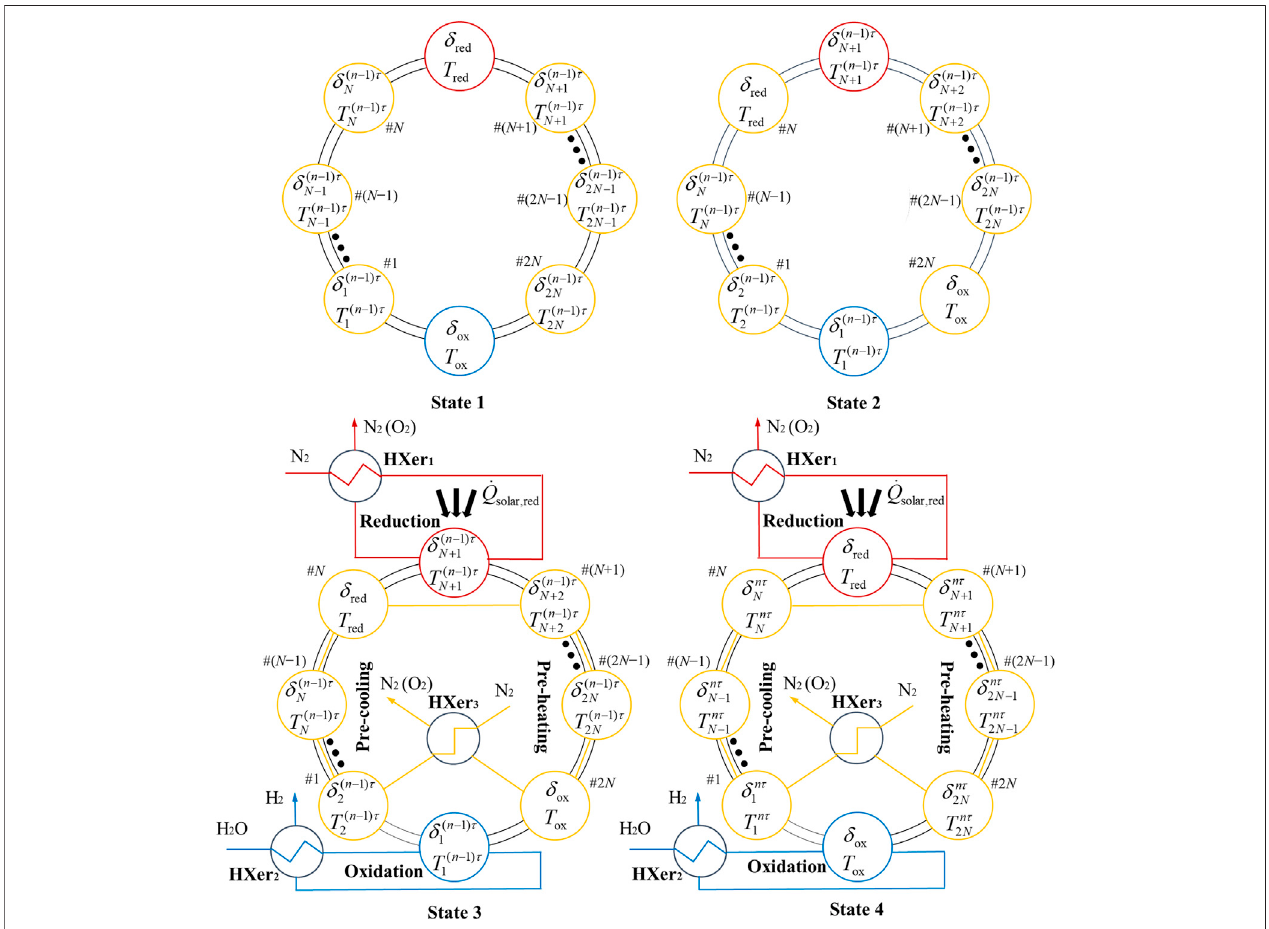
FIGURE 3 | Operating procedure (4 states) for the n th redox cycle. N 2 (O 2 ) represents N 2 mixed with O 2 . State 1: initial state of the n th cycle; State 2: “ rotated ” counter-clockwise in one phase; State 3: begin of reaction or the ( n − 1) τ time instant; State 4: fi nal state of the n th cycle or the n τ time instant. The red, blue, and yellow arrowsindicatemass fl owsinreduction,oxidation,andrecuperationzones,respectively.Theblackthickarrowsindicatethe fl owofenergy.TheCRRsandtheHXer 3 are connected in series by pipes, which are not shown in this fi gure.